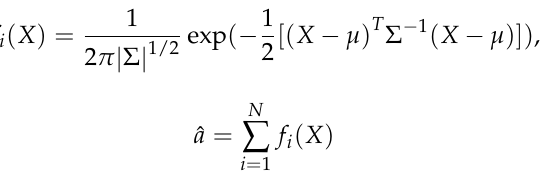
Figure 7. Input image and soft label.